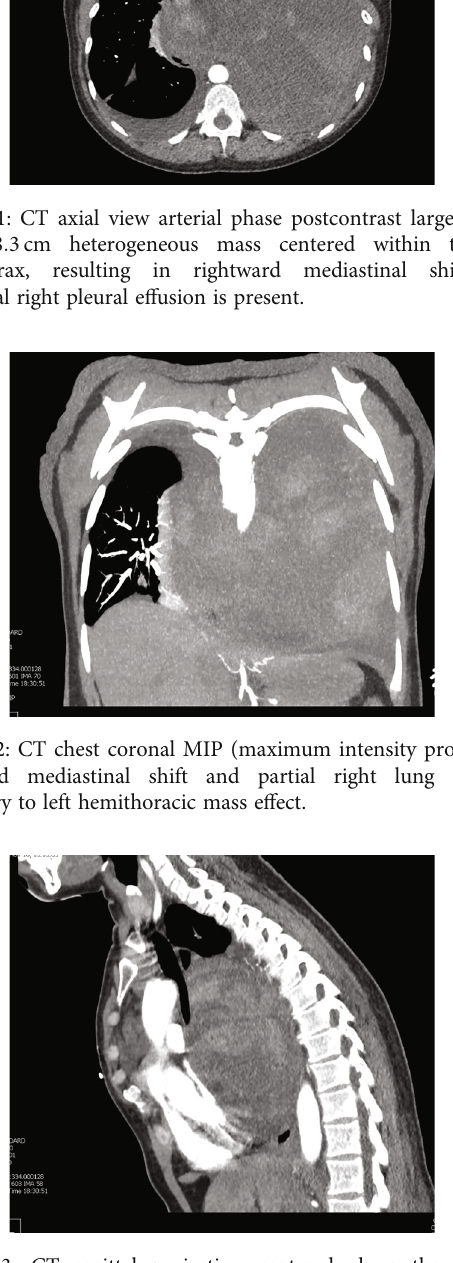
Figure 3: CT sagittal projection centered along the midline depicted anterior displacement of mediastinal structures secondary to larger left hemithoracic mass, which crosses the